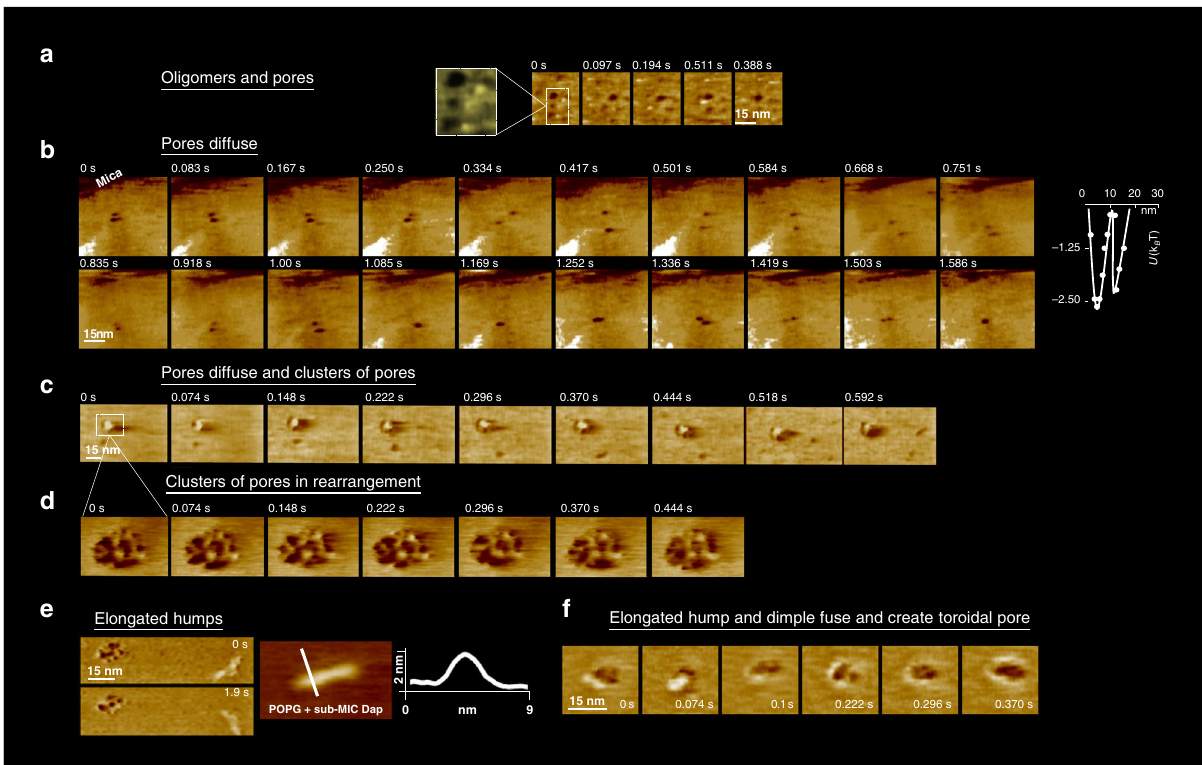
Fig. 4 Sub-MIC Dap on POPG at 37 °C. Tens of minutes. Intermediate stages a A new structure appeared: dimples, zones of thinner membrane thickness, whose diameter was in the range 7 ± 2 nm. Most dimples diffuse, but some remained static (colour scale: 3 nm). Movie details: frame rate 97 ms; zoom of a full image of 150 nm × 90 nm and 256 × 160 pixels. b The dimple diffusion consisted of swinging trajectories, implying membrane-mediated dimple-dimple attraction (colour scale: 3 nm). b , right, Energy pro fi le of the interaction of the dimples obtained derived from 120 centre-to-centre distance measurements that contains as the oligomers two energy minima. Movie details: frame rate 83 ms; full image of 150 nm × 150 nm and 256 × 256 pixels. c In some membrane zones, clusters of dimples, reminiscent of cubic phases, developed (colour scale: 4 nm). Movie details: frame rate 74 ms; full image of 90 nm × 60 nm and 256 × 160 pixels. d The clusters of dimples were moderately dynamical in time, with moderate internal rearrangements (colour scale: 4 nm). Movie details: frame rate 74 ms; full image of 25 nm × 16 nm and 256 × 160 pixels. e The other deformation found was elongated-humps on top of the POPG membrane. e , left, An elongated-hump in the proximity of a cluster of dimples (colour scale: 4 nm). e , right, A close-up and a pro fi le of an elongated- hump. Additional images of elongated-humps on Supplementary Fig. 1. Movie details: frame rate 479 ms; zoom of full image of 250nm × 200 nm and 300 × 256 pixels. f It was observed that the dimples and the elongated-humps fused and gave yield to pores of toroidal structure where a protruding ring surrounds the pore (colour scale: 4 nm). Movie details: frame rate 74 ms; full image of 40 nm × 40 nm and 256 × 160